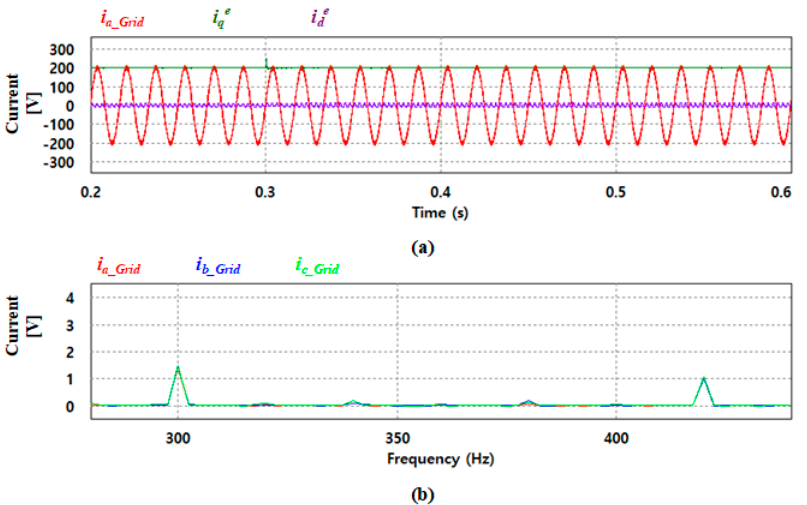
Figure 16. Conventional harmonic compensation method (grid voltage: 311 V → 250 V): ( a ) three-phase grid voltage, a-phase current, and d-q axis current; ( b ) FFT analysis result of three-phase current.